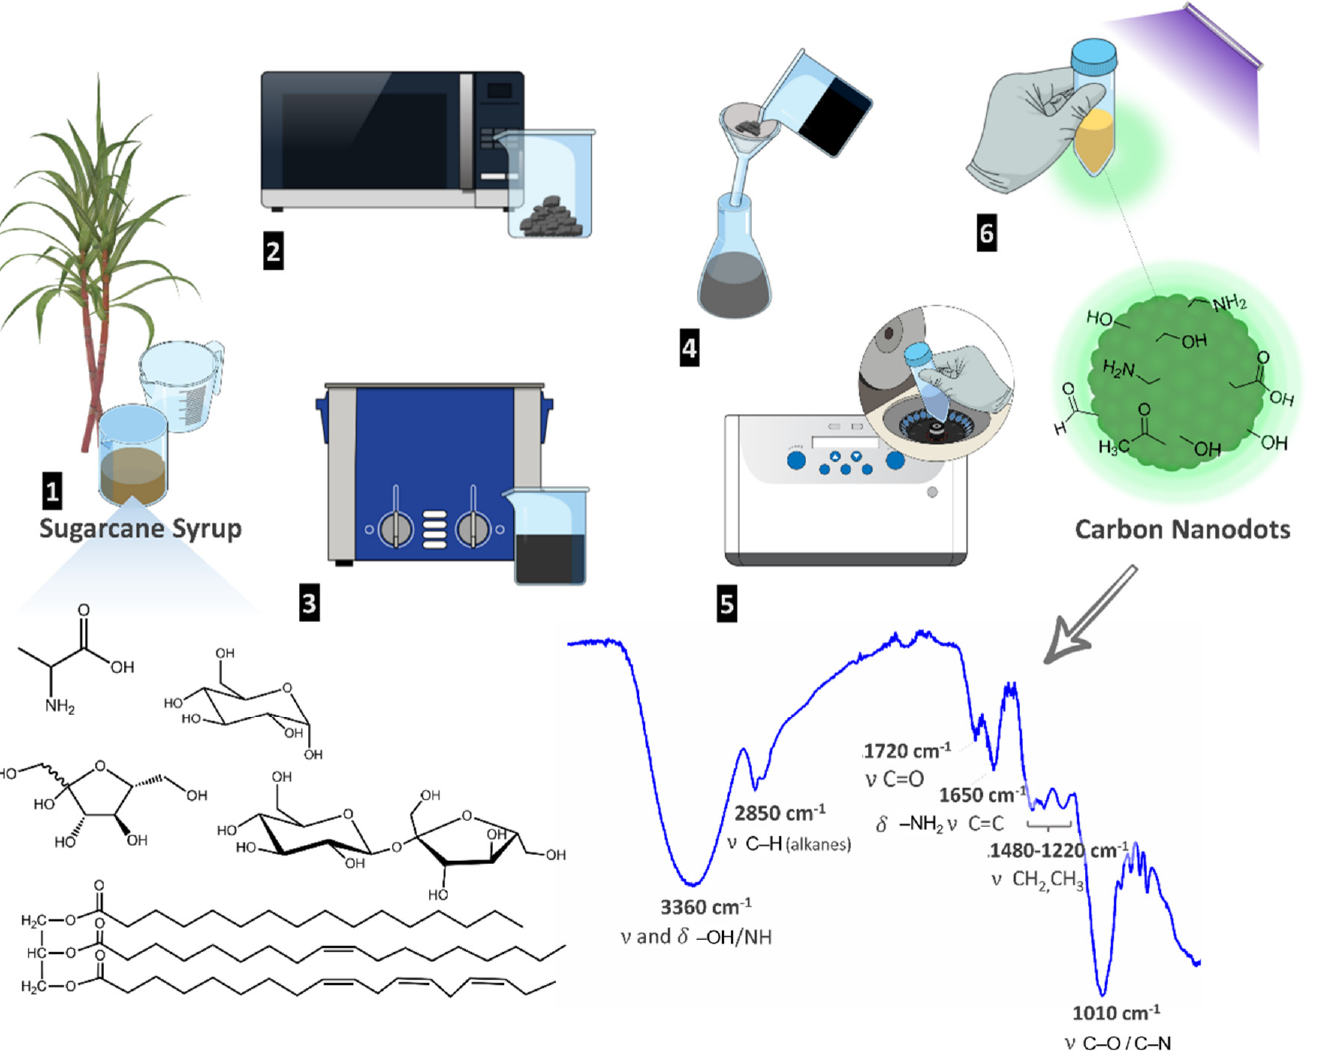
Figure 1. Schematic representation of the new methodology developed to obtain CNDs from sugarcane syrup; chemical structures of the major components of sugarcane syrup, schematic representation of the resulting CNDs, and FTIR spectrum of the CNDs with the assignment of the most important bands. The major components of sugarcane syrup are sucrose, glucose, fructose, amino acids, lipids, and inorganic salts containing K, Ca, Na, Fe, and Mg, among others [42]. Sugar- cane syrup was diluted in deionized water and heated in a domestic microwave oven (700 W, 20 L), using a two-cycle process (1 min + 30 s) cycle. The obtained carbonized material was re-dispersed in deionized water using an ultrasound bath, and the mixture was filtered through filter paper to remove the bulk material, yielding a